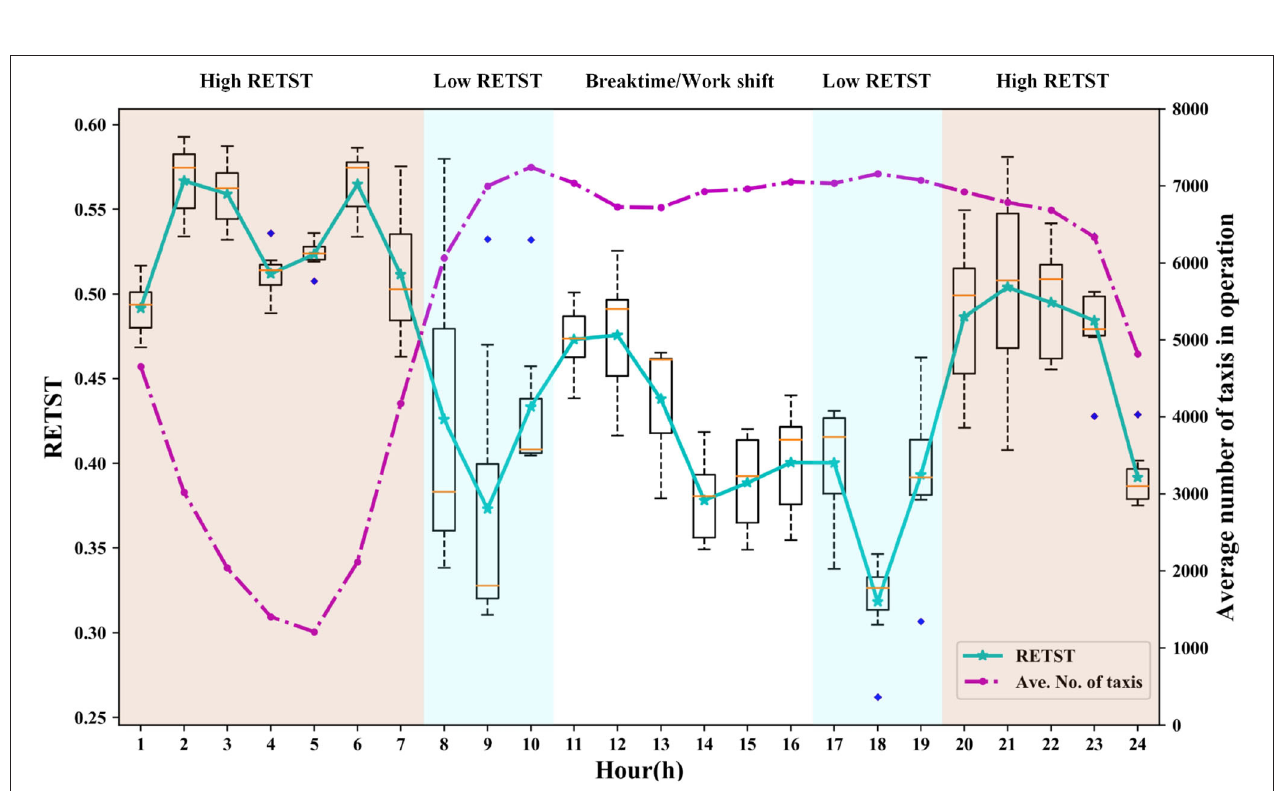
FIGURE 3 | Profiles of the ratio of empty/total service time (RETST) and the average number of taxis in operation.